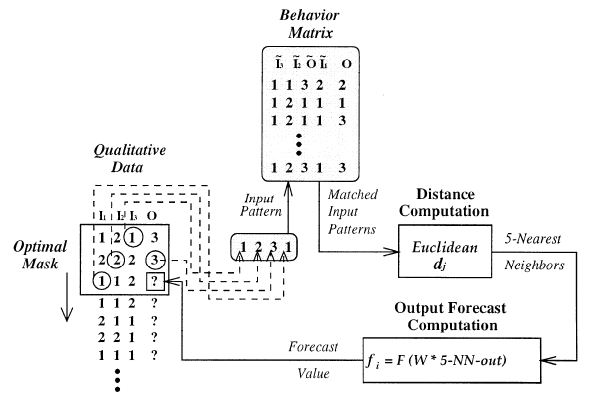
Fig. 3. Fuzzy forecasting FIR